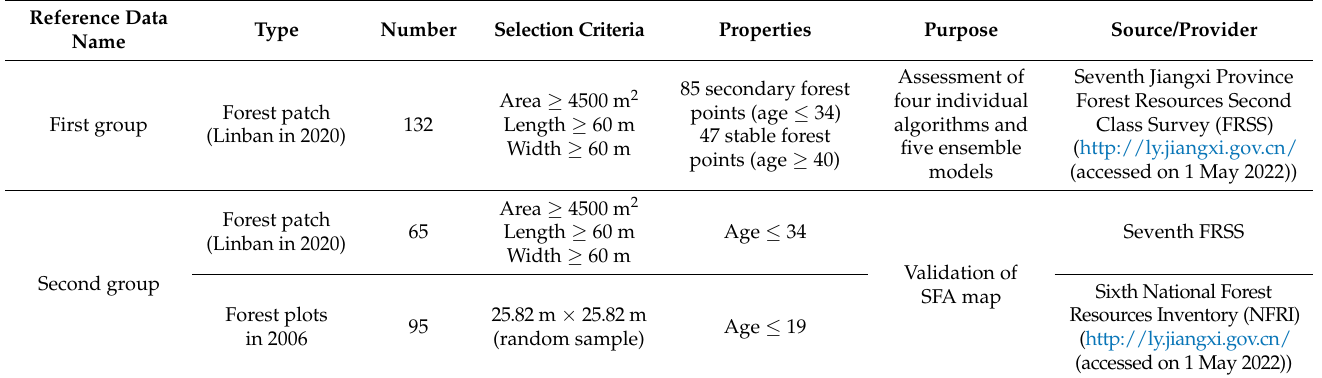
Table 1. Reference data used for assessment of the algorithms and ensemble models and validation of the SFA